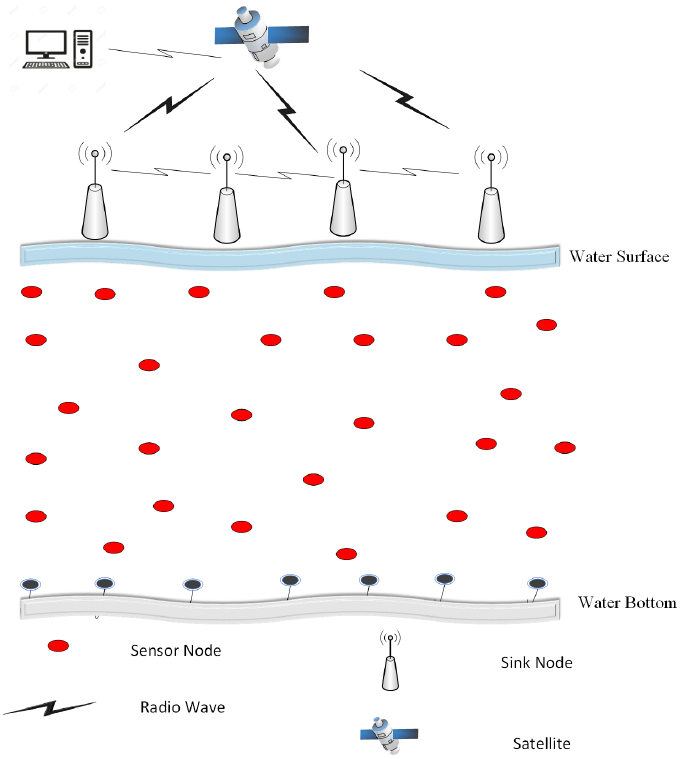
Figure 1. Network